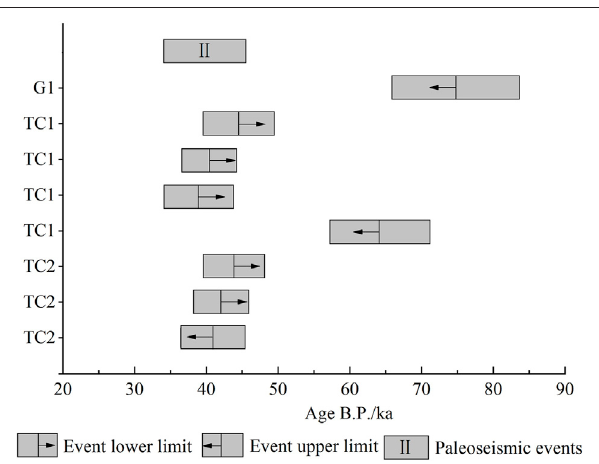
FIGURE 7 | The progessive constrained paleoseismic event in Kouma